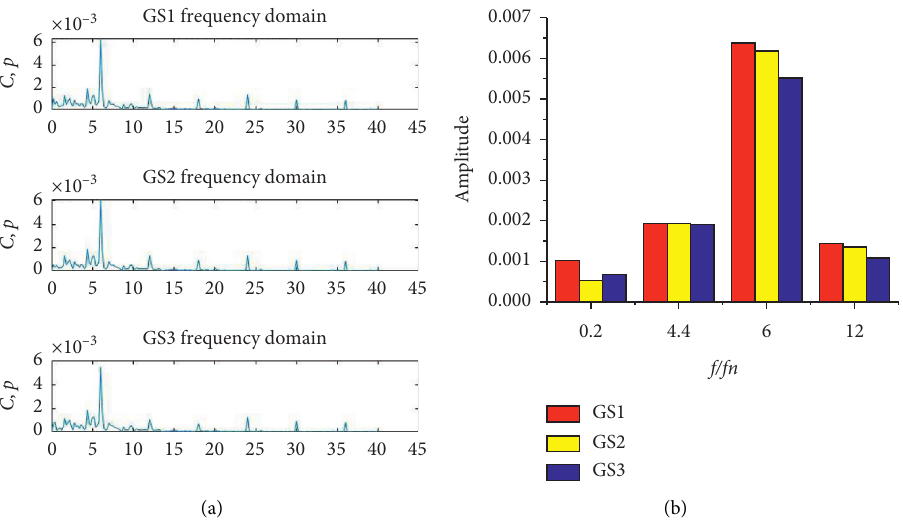
Figure 13: Pressure pulsation of tongue volute. (a) Frequency domain. (b) Amplitude.